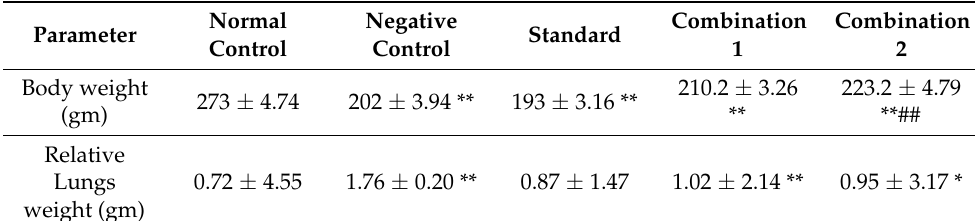
Table 1. Effect of treatment combination on OVA induced alterations in Body Weight and Relative lungs